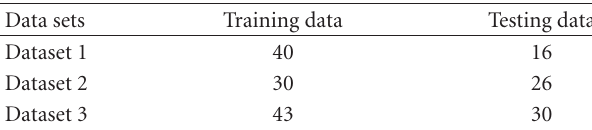
Table 3: Length of data used in di ff erent sets.